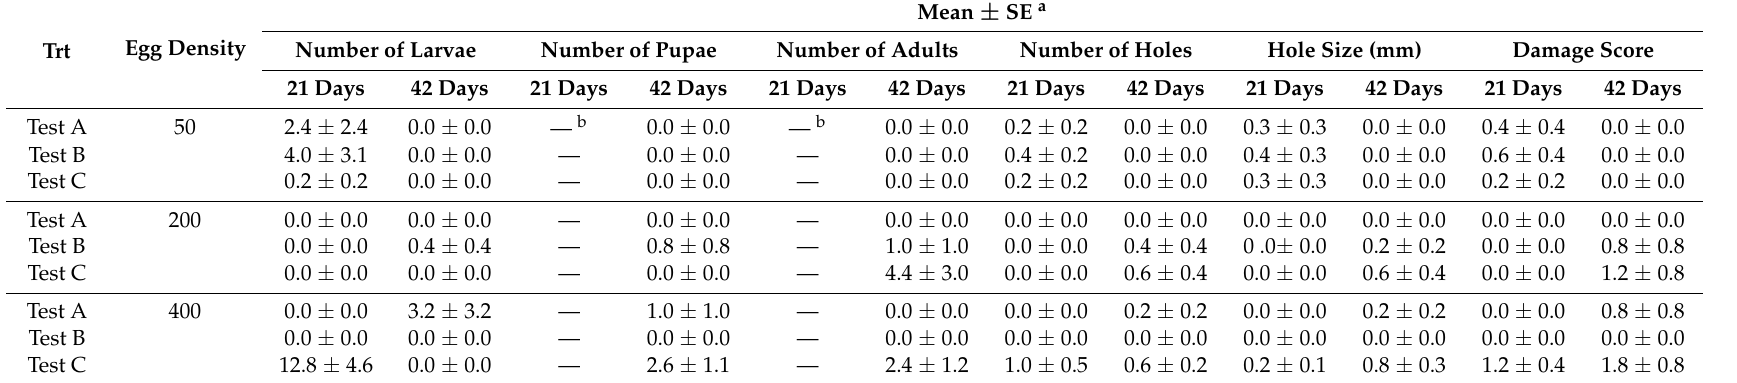
Table 2. Number of larvae, pupae, and adults of P. interpunctella found inside the packages of energy bars after 21 days and 42 days of infestation, and the extent of damage to packages and energy